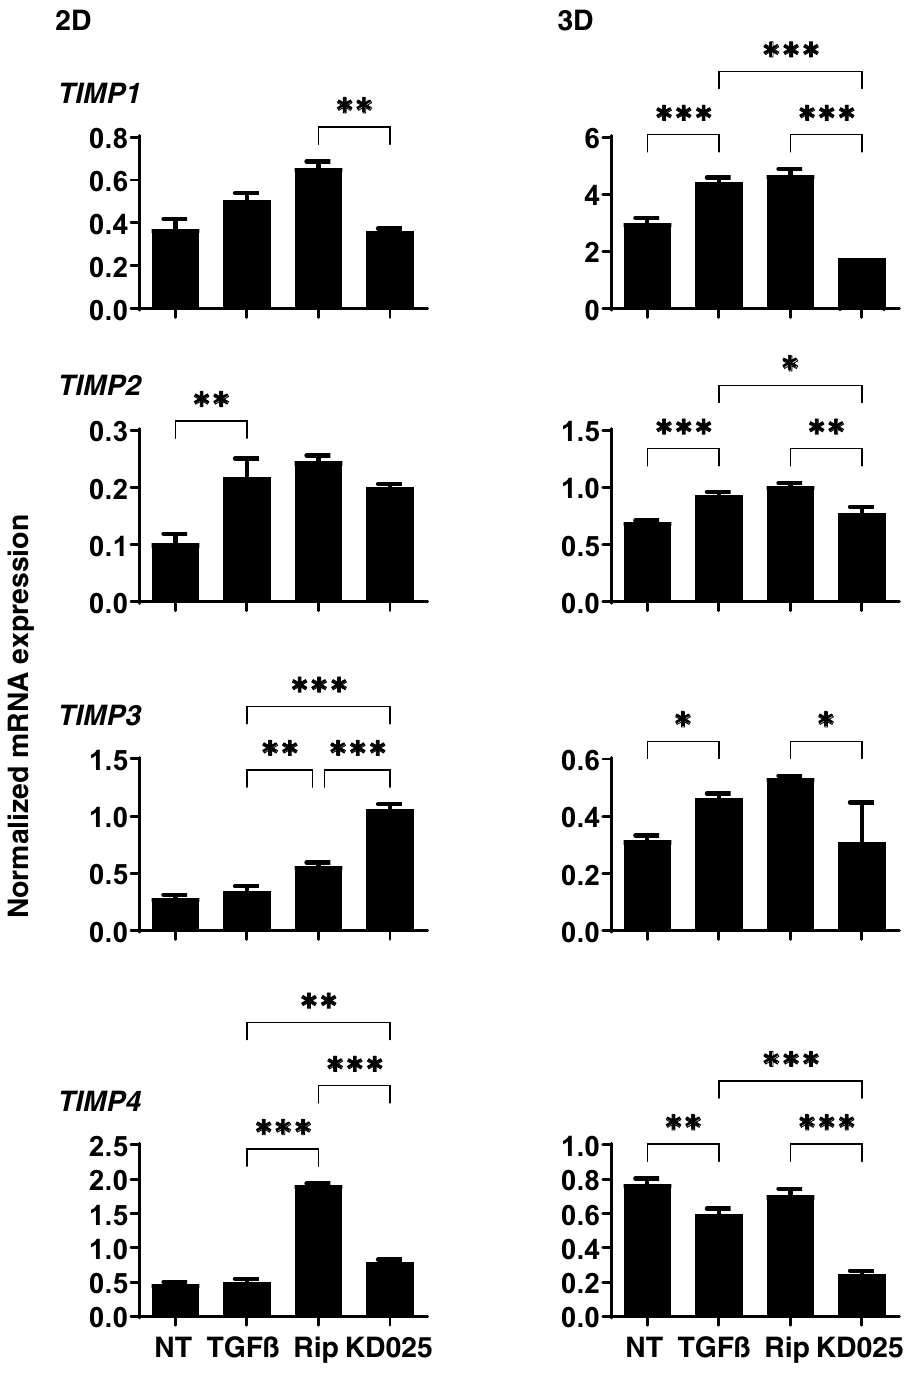
Figure 6. mRNA expression of TIMPs in 2D and 3D cultured HTM cells. At Day 6, HTM 2D cells and 3D sphenoids (control) and those treated by 5 ng/ml TGFβ2 in the absence or presence of 10 μM ripasudil (Rip) or KD025 were subjected to qPCR analysis to estimate the expression of mRNA in TIMP1-4 . All experiments were performed in duplicate each using 15–20 freshly prepared 3D HTM sphenoids in each experimental condition. Data are presented as the arithmetic mean ± standard error of the mean (SEM). * P < 0.05, ** P < 0.01, *** P < 0.005 (ANOVA followed by a Tukey’s multiple comparison